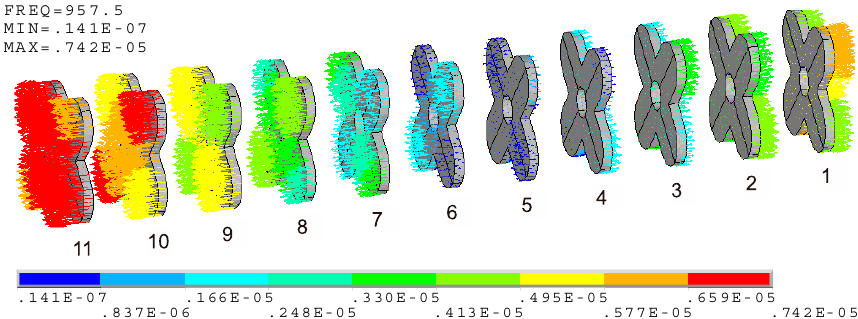
Figure 8. Vector illustration of vibration at 957.5 Hz (cross-beams).